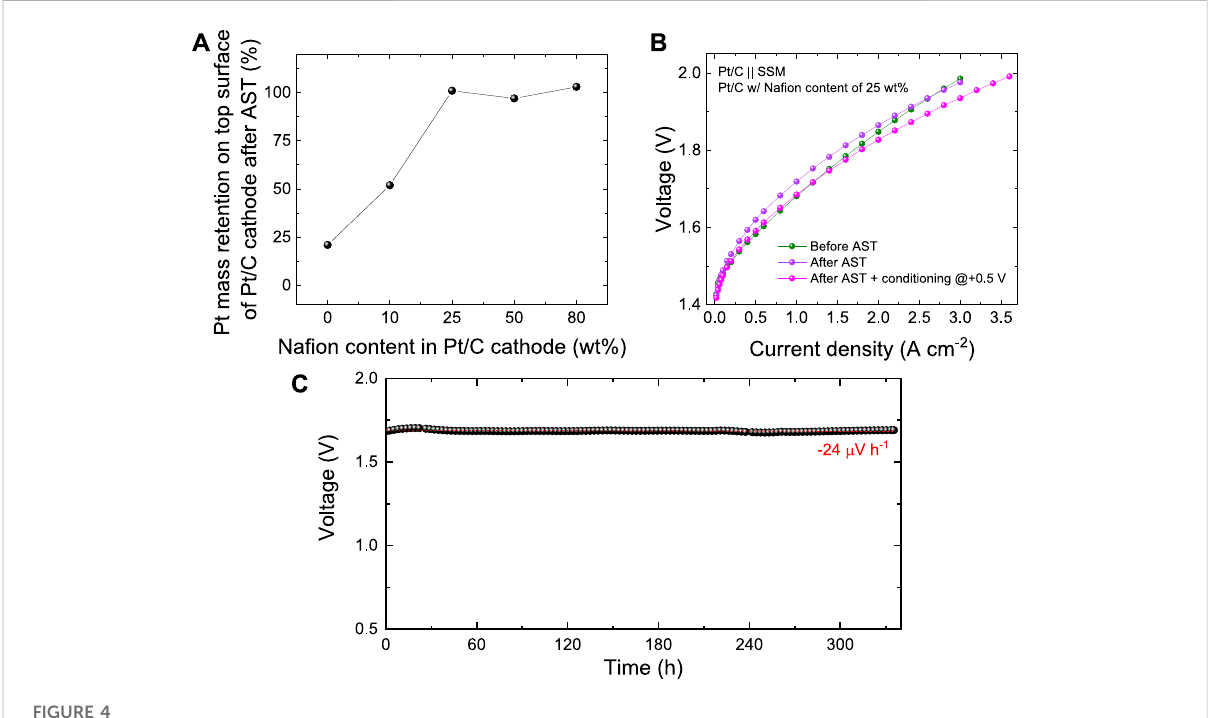
FIGURE 4 (A) Pt mass retention in the catalyst layer (top surface of the Pt/C cathode) after AST as a function of Na fi on content in the catalysts layer. (B) Galvanostatic polarization curve of the AEL based on Pt/C produced with 25 wt% Na fi on content in the catalysts layer, before and after tests, as well asafterafurtherelectrochemicalconditioningoftheAST-testedAEL. (C) Continuousstabilitytest(CPprotocolat1.0 Acm − 2 )oftheAELbasedonPt/ C produced with 25 wt% Na fi on content in the catalysts layer. The red dashed line is the linear fi t of the